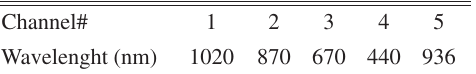
Table I. Sun photometer nominal centre wavelengths.